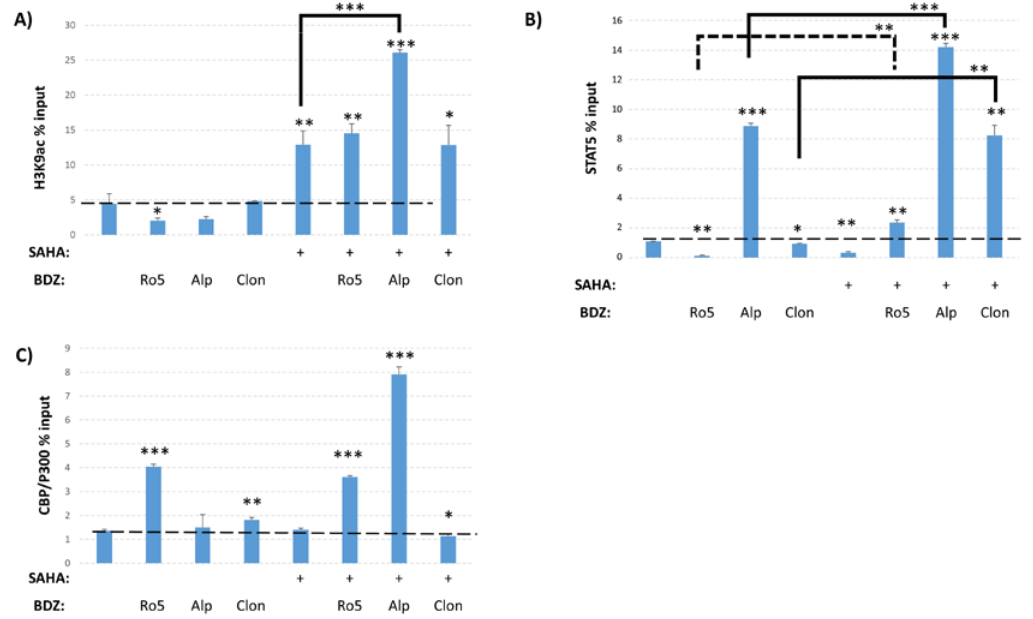
Figure 7. Epigenetic changes driven by Ro5-3335, Alprazolam, and Clonazepam. ChIP was performed to test the effect of Alprazolam and Clonazepam on occupancy of the HIV-1 LTR. TZMbl cells were treated with 10 µM Ro5-3335, Alprazolam, or Clonazepam in the presence or absence of 5 µM SAHA. ChIP was performed using antibodies against ( A ) H3K9ac, ( B ) STAT5, and ( C ) CBP/P300. Primers against HIV U3 LTR were used for qPCR. * P ≤ 0.05, ** P ≤ 0.01, *** P ≤ 0.001. Ro5: Ro5-3335, Alp: alprazolam, Clon: clonazepam.